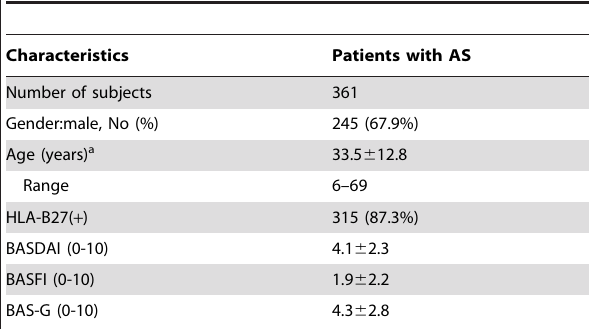
Table 1. Basal characteristics and clinical features of patients with ankylosing spondylitis (AS).